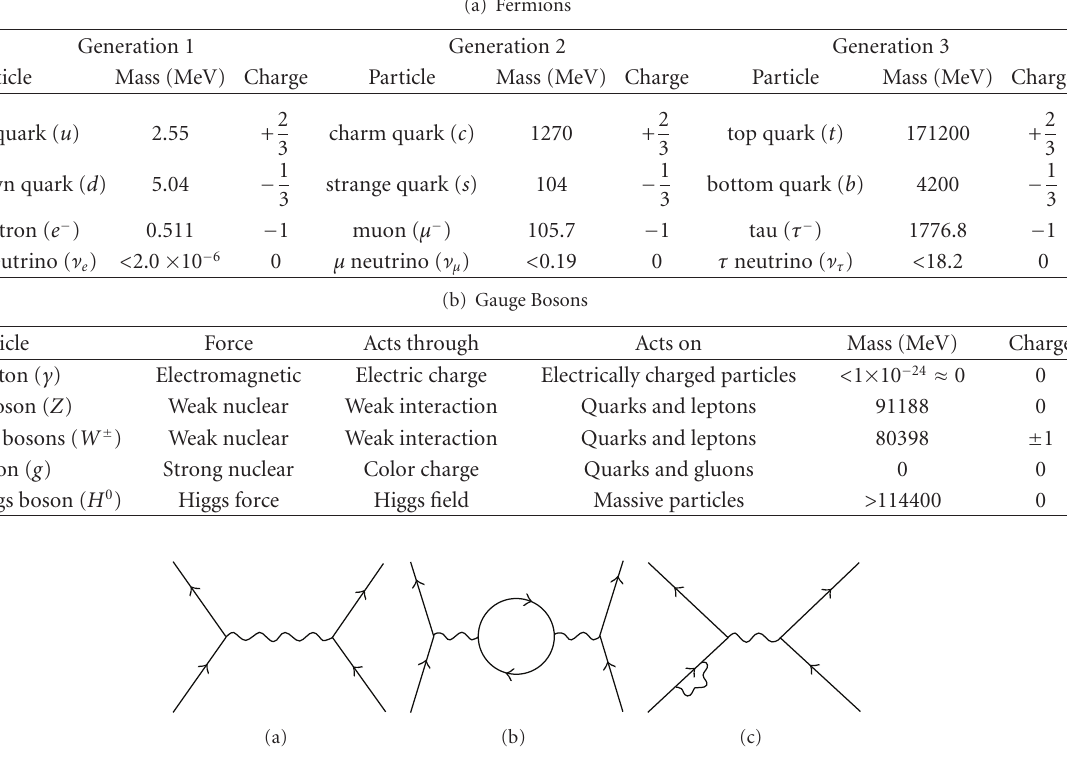
Table 1: The particles predicted by the Standard Model. Approximate masses of particles as last reported by the Particle Data Group [30].